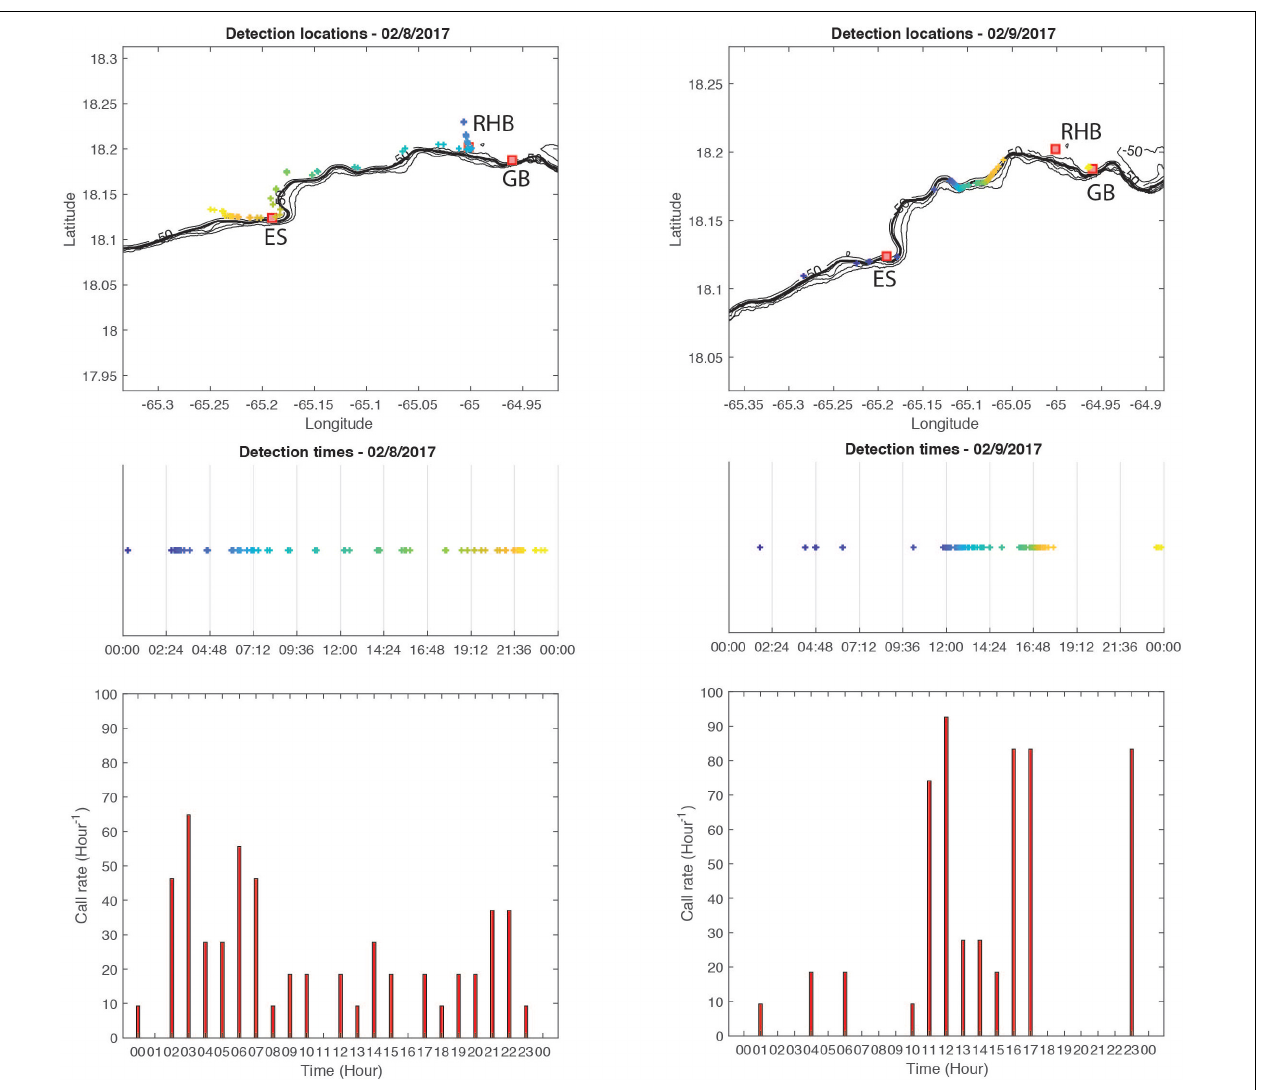
FIGURE 9 | Example of variations in red hind CAS location distribution over two consecutive surveys of the same area. Left column show detection location (top) , local time of detection (middle) , and hourly call rate (bottom) for 08 February, 2017 and right column shows the same variables for 09 February, 2017. The detection locations are colored by time shown in the middle